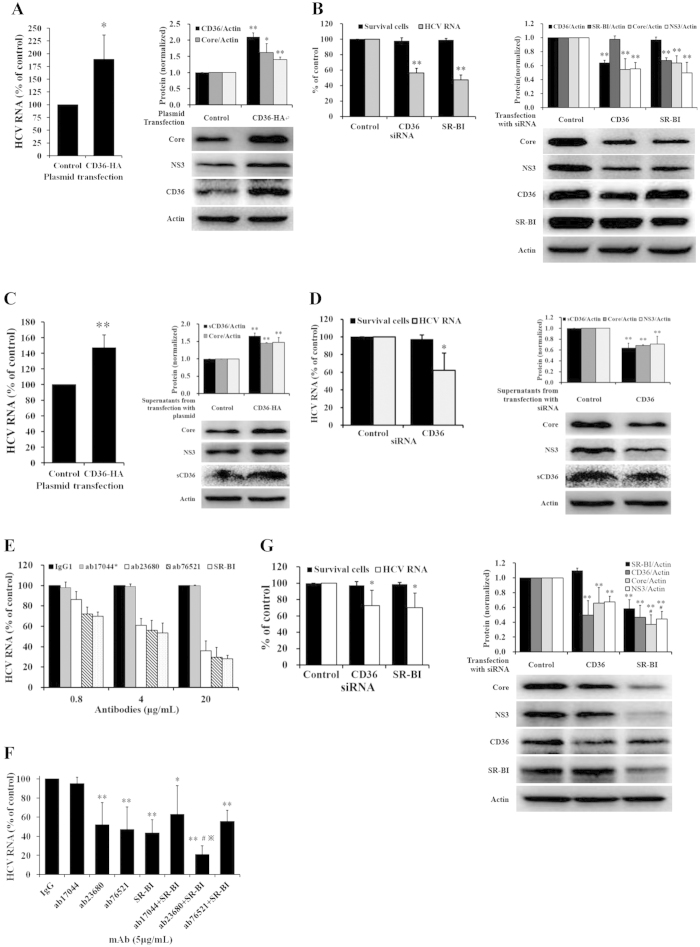
HCV replication was increased by CD36.(A) High expression of CD36 increased HCV infection and replication (n = 3). (B) Silence of CD36 decreased HCV infection and replication (n = 3). Huh7.5 cells were transfected with 0.2 μg CD36-HA plasmid (A) or with 150 pmol siRNA for CD36 (B) for 48 hrs, and then were washed and infected with HCV (150 IU/cell) for 2 hrs, followed by washing and continuously incubating. Intracellular HCV RNA and proteins were detected in 96 hrs, and the cytotoxicity of siRNAs was measured in 96-wells plate with a MTT assay in B. (C) High sCD36 in supernatants increased HCV infection (n = 3 for RNA, n = 4 for protein). (D) Low sCD36 in supernatants decreased HCV infection (n = 3 for RNA and cytotoxicity, n = 4 for protein). Huh7.5 cells were incubated with culture supernatants of Huh7.5 cells transfected with 0.2 μg CD36-HA plasmid (C) or with 150 pmol siRNA for CD36 (D) for 48 hrs, and infected with HCV (150 IU/cell) for 2 hrs, followed by washing and continuously culturing. Intracellular HCV RNA and proteins were detected in 72 hrs, and cytotoxicity was measured with a MTT assay accordingly in D. The pcDAN3.1(+) vector was used as plasmid control in A and C. The SR-BI siRNA (sc-44753) was used as positive control and siRNA-A as negative control in (B). *P < 0.05 and **P < 0.01, vs control; #P < 0.05, vs CD36 siRNA. (E) CD36 mAbs neutralized HCV infection in a dose-dependent manner (concentrations of ab17044 were 0.2, 1, and 5 μg/mL) (n = 3). (F) CD36 mAbs synergistically inhibited HCV infection with SR-BI antibody (n = 4). Huh7.5 cells were incubated with 5 μg/mL mAb for 1 hr and then infected with HCV (150 IU/cell) for 2 hrs, followed by washing and culturing. Intracellular HCV RNA was detected in 72 hrs (E,F). *P < 0.05 and **P < 0.01, vs IgG group; #,P < 0.05, vs monotherapy with ab23680 or SR-BI antibody. The mAbs code was from Abcam, Co. Ltd. (G) Cross-silencing test of CD36 and SR-BI (sc-44752), and cytotoxicity was measured with a MTT assay (n = 3 for RNA and cytotoxicity, n = 6 for protein). The protein bands presented in the figure showed the results of a representative experiment. Presented are mean ± standard deviation. Student’s t-test was used in (A–G).